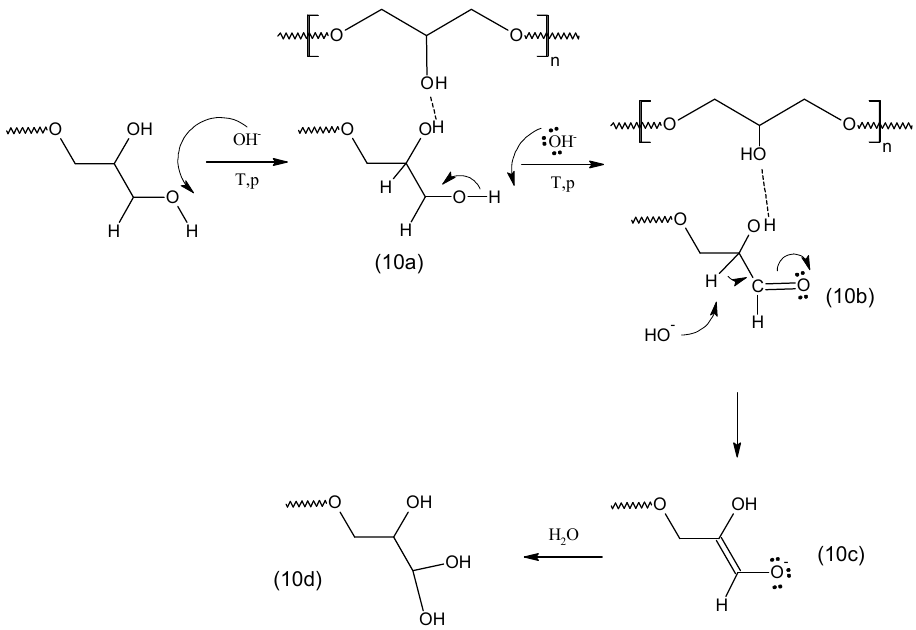
Figure 10. Proposed mechanism of formation of two hydroxyl groups.